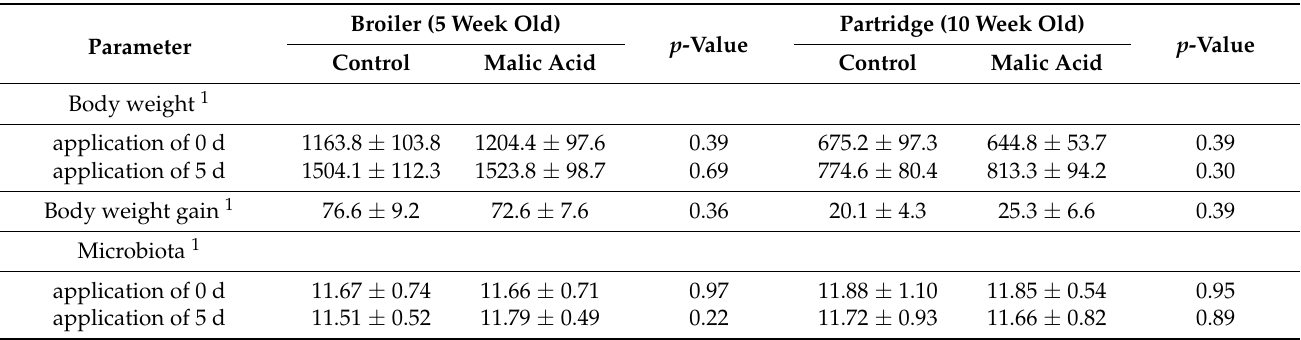
Table 1. Body weight (g), body weight gain (g/day), and intestinal microbiota (log 10 CFU/g) of broilers and partridges receiving malic acid-supplemented drinking water at slaughter age.